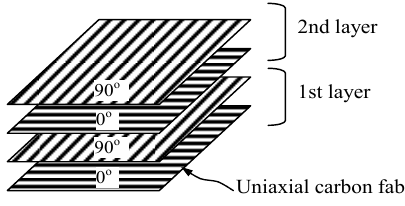
Figure 2. Lay-up arrangement of CFRP laminates.